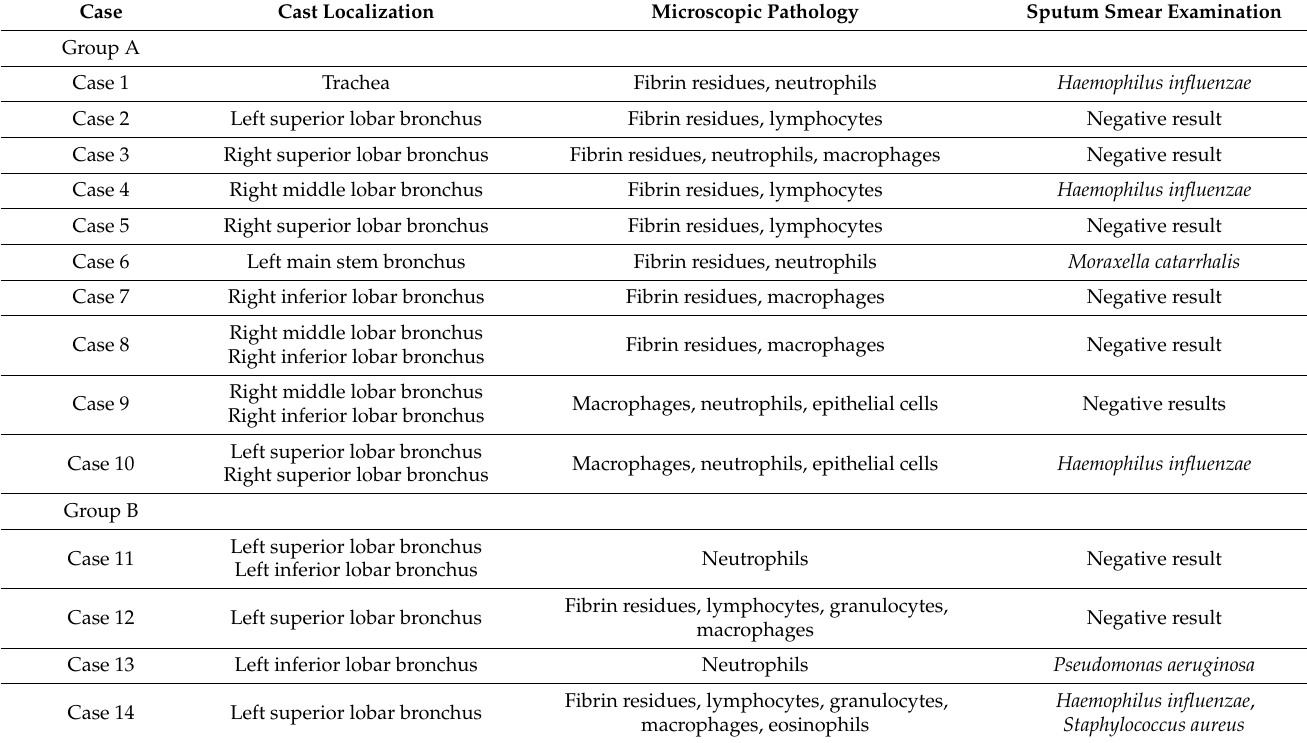
Table 3. Airway cast location and histopathologic